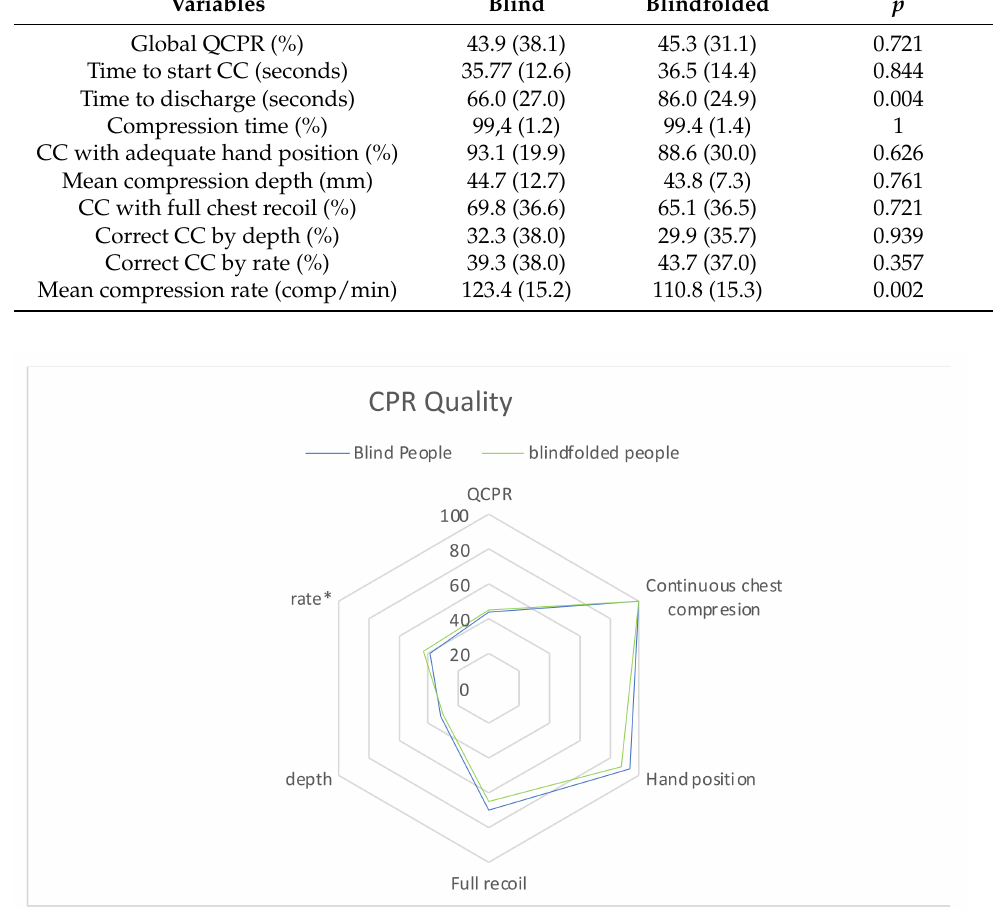
Figure 2. Assessment of chest compressions quality elements in blind and blindfolded people. * p < 0.005. The percentage of BP subjects who achieved the recommended CC depth target was 27.6%, compared with 23.3% of BFP ( p = 0.288). When the target was arbitrarily expanded to 10% below the lower limit and 8% above the upper limit (45–65 mm), it was achieved by 58.6% of BP and 43.3% of BFP individuals ( p = 0.18) (Figure 3). For the CC rate target, it was achieved by 48.3% of BP and 36.7% of BFP participants ( p = 0.025). When this target was arbitrarily expanded to 10% below the lower limit and 8% above the upper limit (90–130 CC/min), it was achieved by 72.4% of BP and 83.3% of BFP subjects ( p = 0.24) (Figure